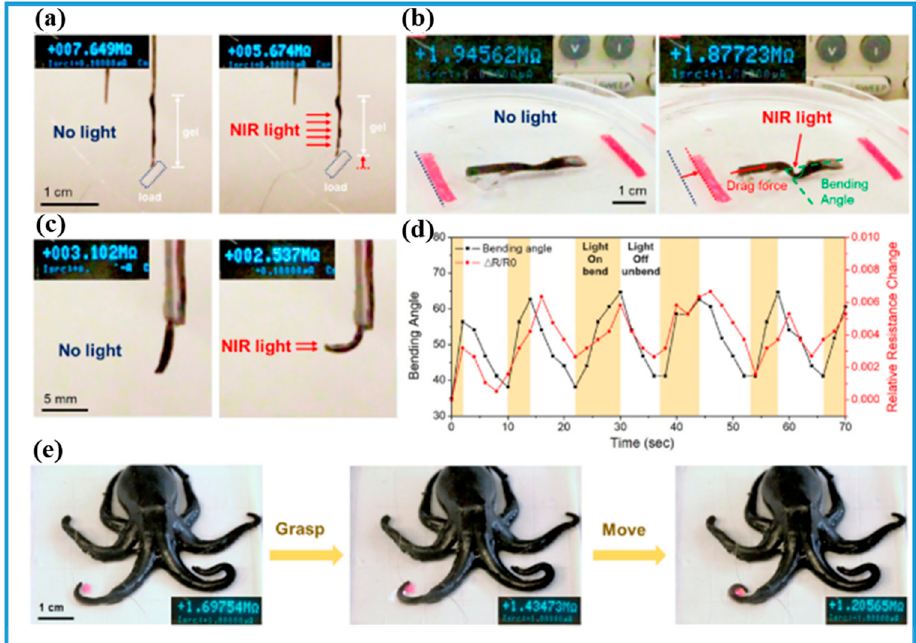
Figure 12. ( a ) Pictures of loading behavior of PNIPAM-ECH hydrogel triggered by NIR light. ( b ) Pictures of bending behavior of PNIPAM-ECH hydrogel triggered by NIR light. ( c ) Actuation behavior of octopus-like PNIPAM-ECH hydrogel. ( d ) Bending angle and resistance change curves of PNIPAM-ECH. ( e ) Actuation behavior of octopus-like PNIPAM-ECH hydrogel. Copyright from Ref. [100] Elsevier.